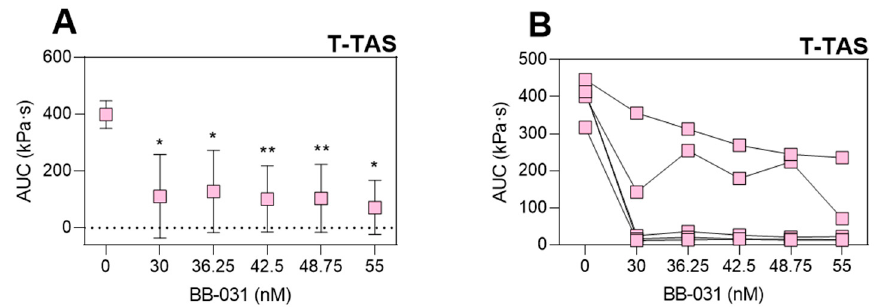
Figure 2. T-TAS inhibition at lower concentrations of BB-031. As function was maximally inhibited at the lowest dose of drug in the selected dose response curve, another dose–response curve for this assay alone was generated. The same data are shown as ( A ) summary data (mean ± standard deviation (SD) and ( B ) individual data points. N = 5. ** p < 0.01, * p < 0.05.